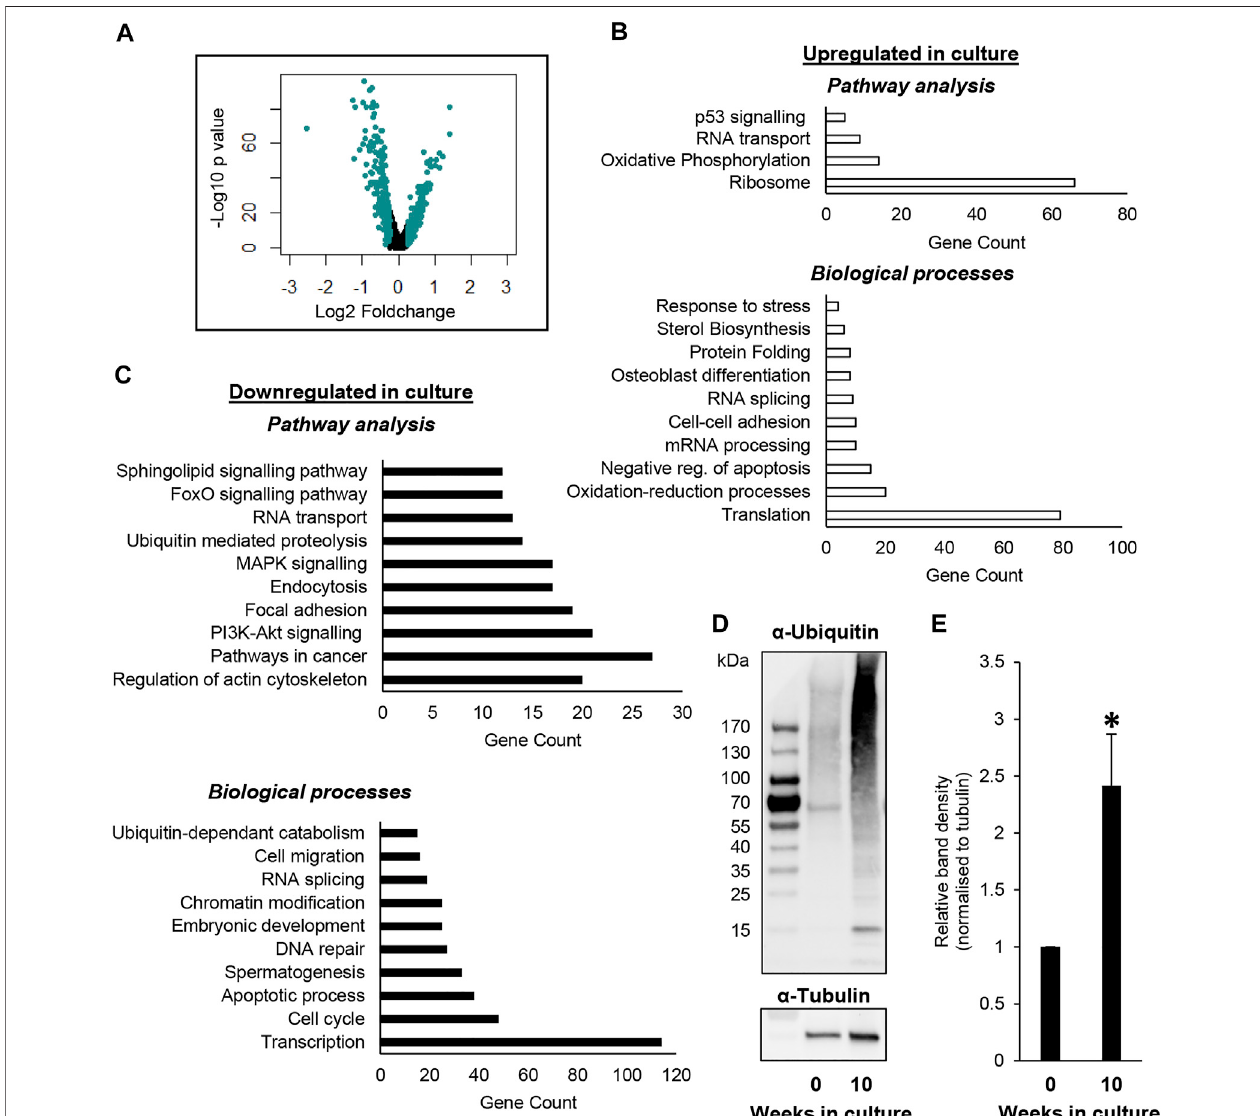
FIGURE 3 | Identifying DEGs between undifferentiated spermatogonia from culture versus the testis. (A) Volcano plot depicting Log2 foldchange and – Log10 p value of DEGs identi fi ed in a comparison of ‘ SSC_0 ’ (testis predominant) and ‘ SSC_1 ’ (culture predominant) clusters. (B) Analysis identifying pathways and biological processes that are upregulated in SSCs from the SSC_1 cluster. (C) Pathways and biological processes that are downregulated in the SSC_1 cluster. For outputs from DEG analysis see also Supplemental Dataset 1. (D) Immunoblot depicting increased levels of ubiquitinated proteins in undifferentiated spermatogonia following 10 weeks of in vitro culture, as compared to the equivalent SSC-enriched (Thy1+) population taken directly from the testis (i.e. passage 0/week 0). (E) Densitometry analysis demonstrating a signi fi cant increase in ubiquitinated proteins in undifferentiated spermatogonia following 10 weeks of in vitro culture ( n = 3 biological replicates, p <